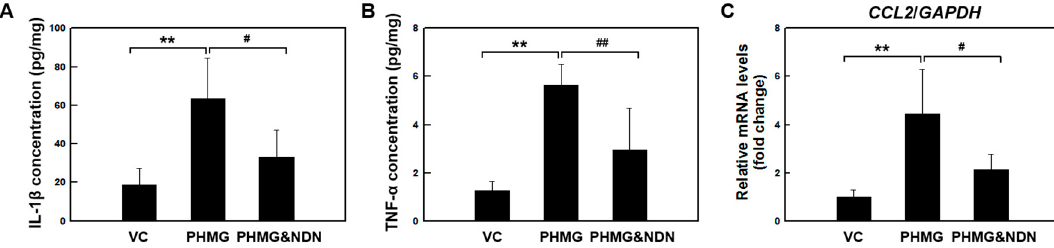
Figure 4. Effect of NDN on the expression of inflammatory factors of mice. The production of IL-1 β and TNF- α in the lung tissue was detected by ELISA ( A , B ). The expression level of CCL2 was determined using qRT-PCR ( C ). Gene expression was presented as fold changes and normalized to GAPDH. Data are presented as the means ± SD ( n = 6/group). ** p < 0.01 vs. VC group, # p < 0.05 and ## p < 0.01 vs. PHMG group.